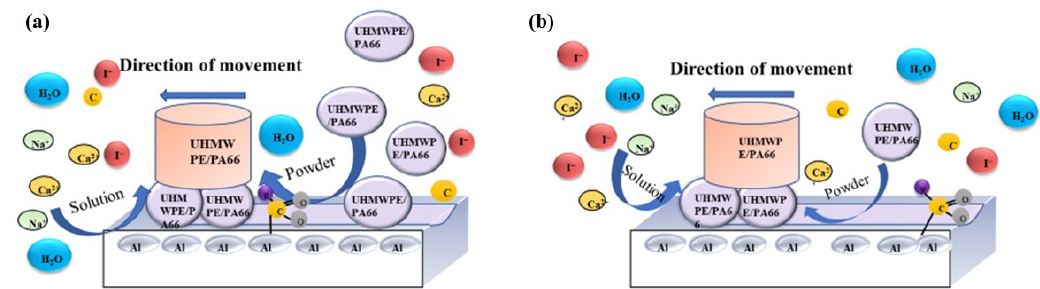
Figure 16. Suggested schematic diagram of lubrication layer formation.( a ) seawater; ( b ) seawater with powder in it.